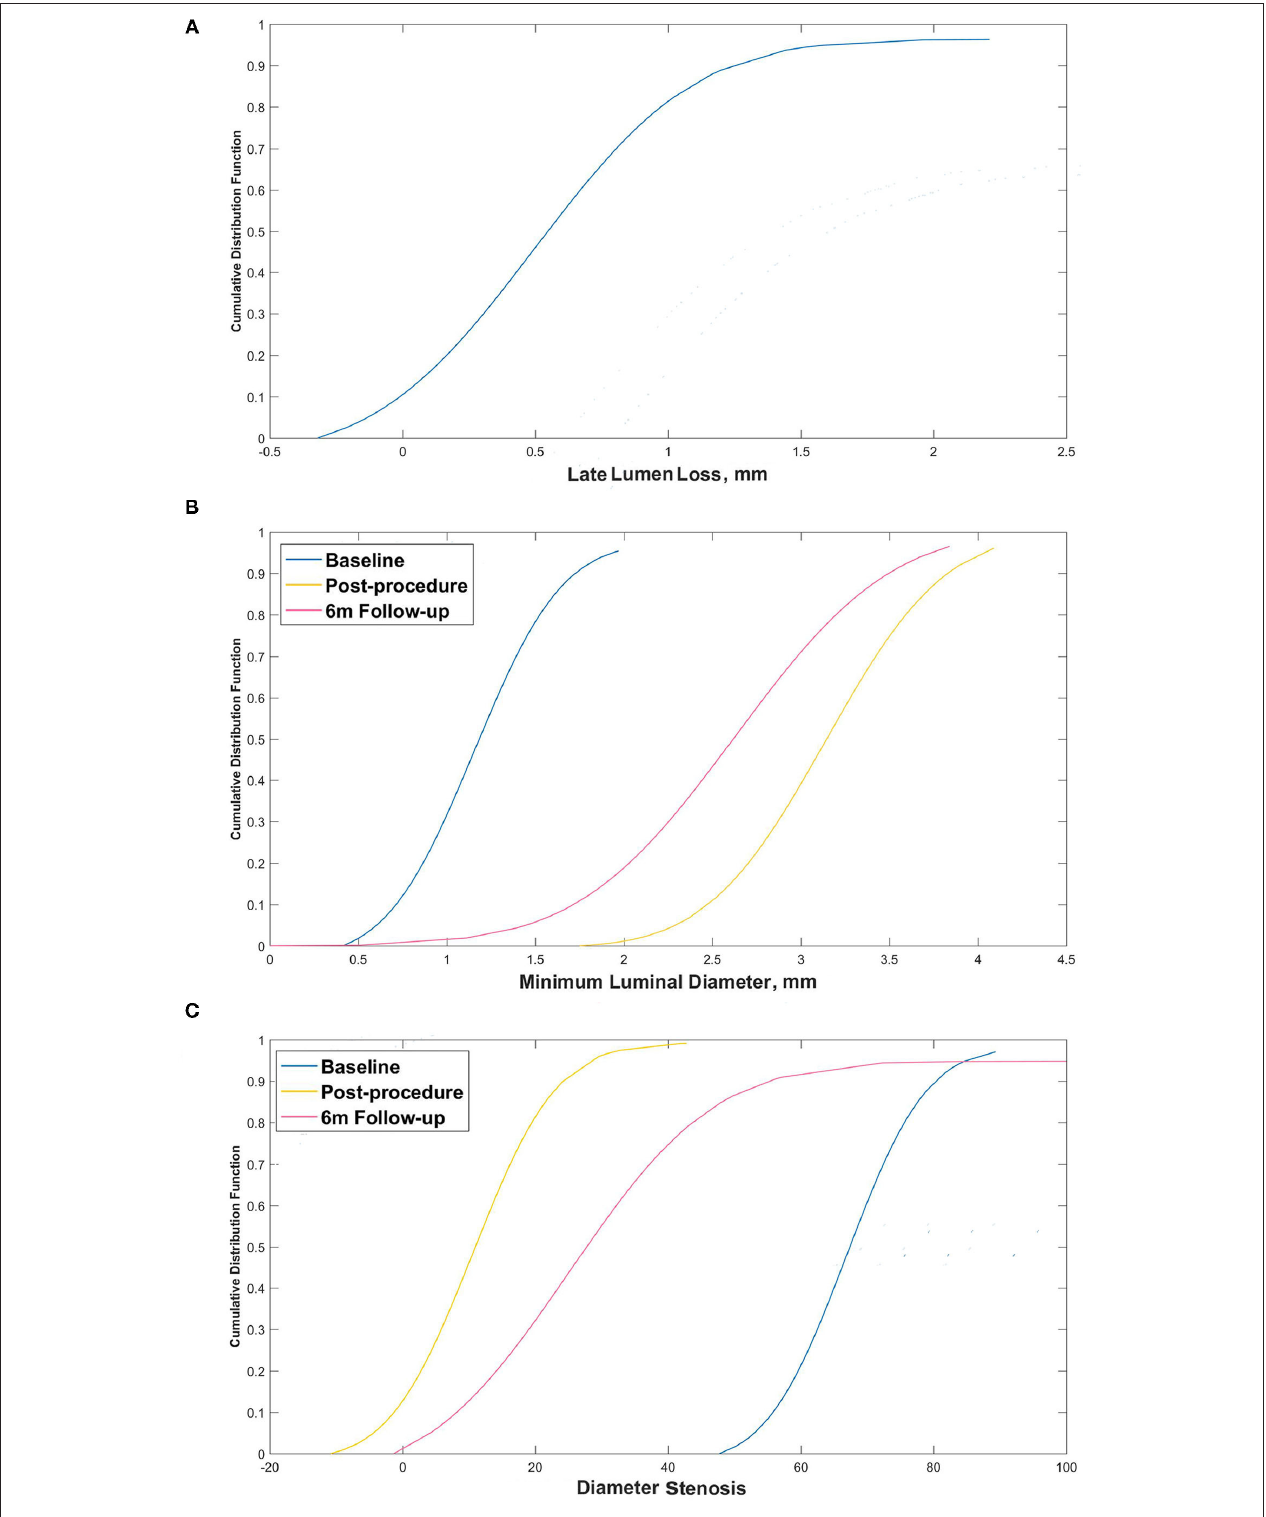
FIGURE 4 | Cumulative frequency distribution curves. (A) Cumulative frequency distribution curve for late lumen loss at 6 months; (B) Minimum luminal diameter pre- and postprocedure and at the 6-month follow-up; and (C) Percentage diameter stenosis pre- and postprocedure and at the 6-month follow-up.